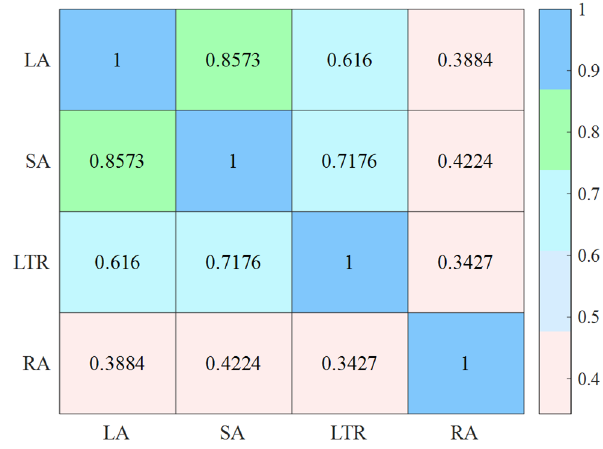
Figure 13. Coefficient matrix of Pearson’s Correlation.